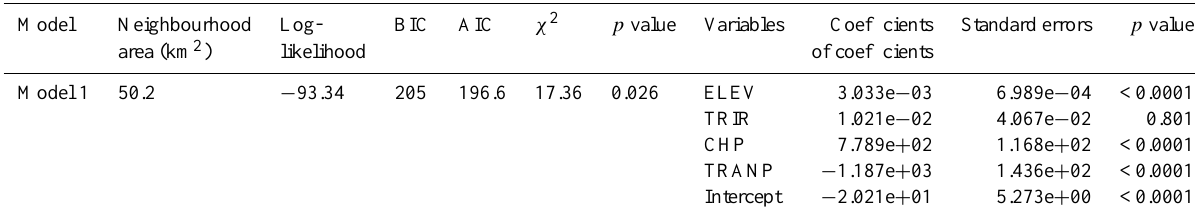
Table 3. The summary of the best RSPF models of lynx habitat used for the SSF model and the model selection estimators. Neighbourhood area is the scale; maximum likelihood estimates with nonparametric bootstrap standard errors ( B = 99), BIC = Bayesian information criteria, AIC = Akaike’s information criterion; χ 2 = chi-squared test statistic, p value = model statistically significance. For the best model the coefficients and their sign is shown along with their standard errors and statistically